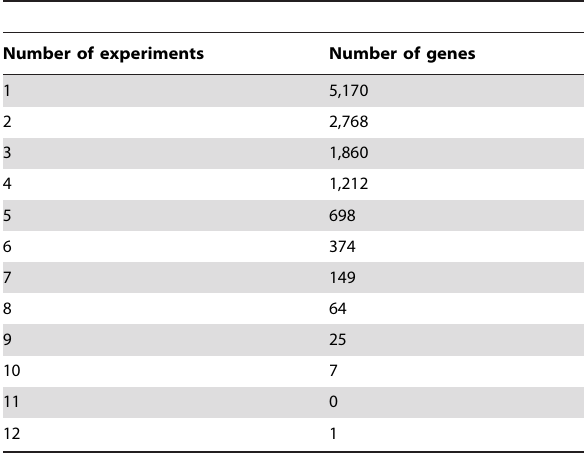
Table 3. Number of genes assigned to modules from different